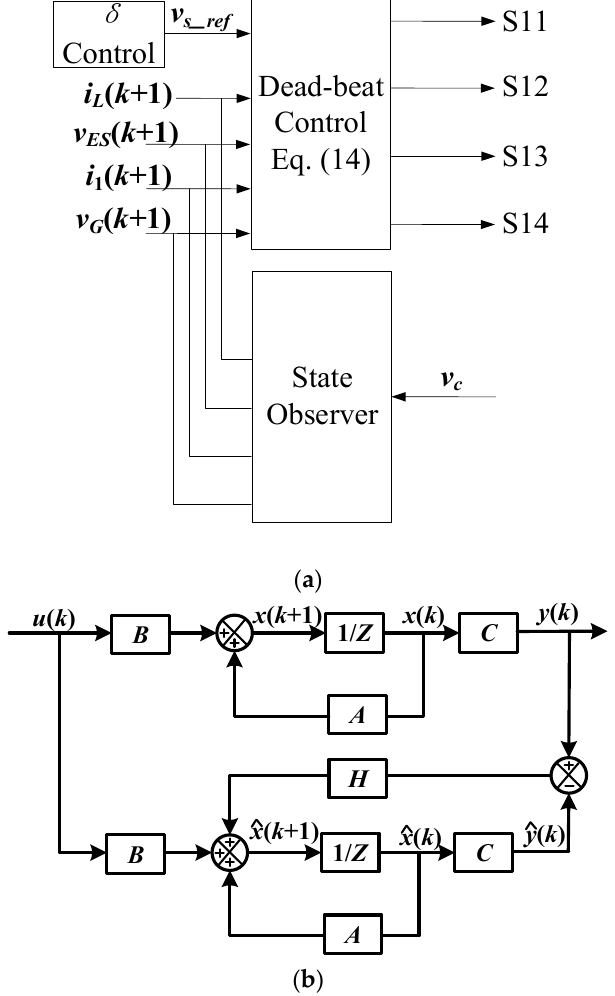
Figure 4. The proposed dead-beat control cooperating with state observer. ( a ) Full control diagram; ( b ) Diagram of the state observer adopted in the control.